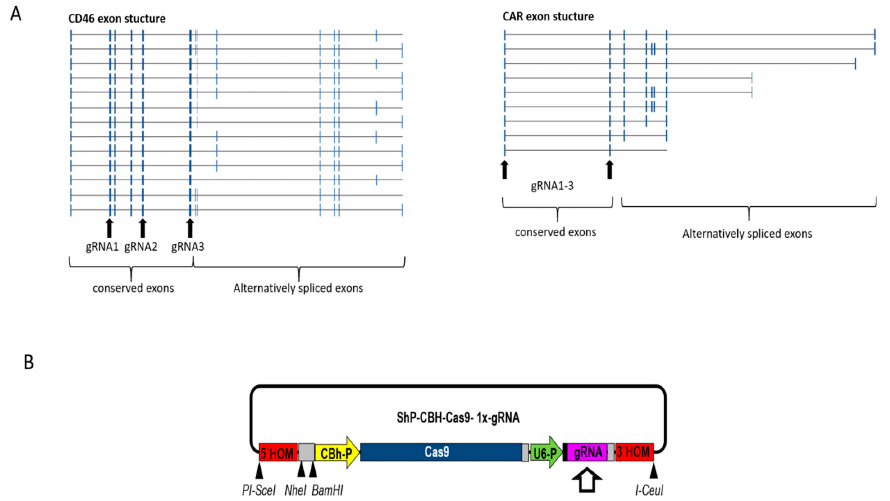
Figure 2. Exon structure of the CD46 and CAR genes and the CRISPR/Cas9 plasmid used for generation of the knockout cell lines. ( A ) Arrow-marked exons in the CD46 and CAR gene regions containing the selected target sites for the gRNAs are translated in all protein isotypes. ( B ) Insertion of gRNA into the customized shuttle vector pShV-CBh-Cas9.